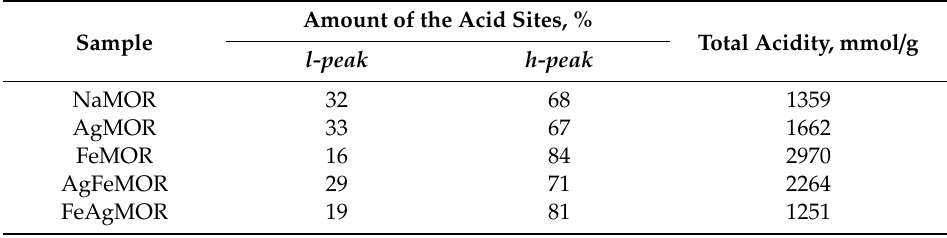
Table 4. Surface acid sites characterization of studied samples by Temperature Programmed Desorption (TPD) of adsorbed NH 3 .